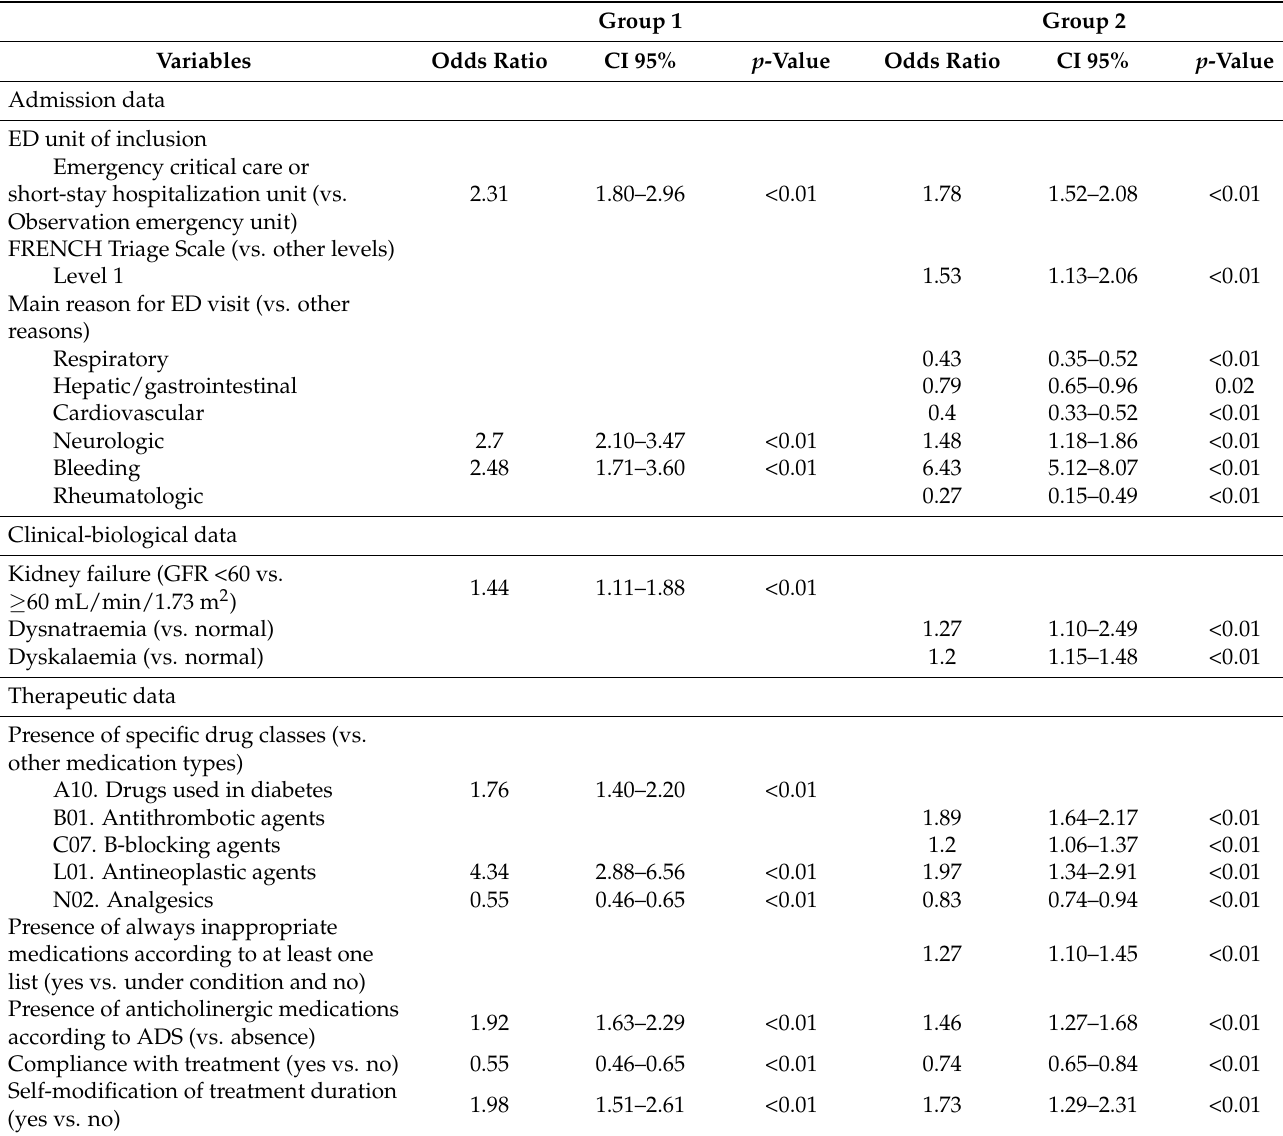
Table 4. Multivariable analyses of variables associated with